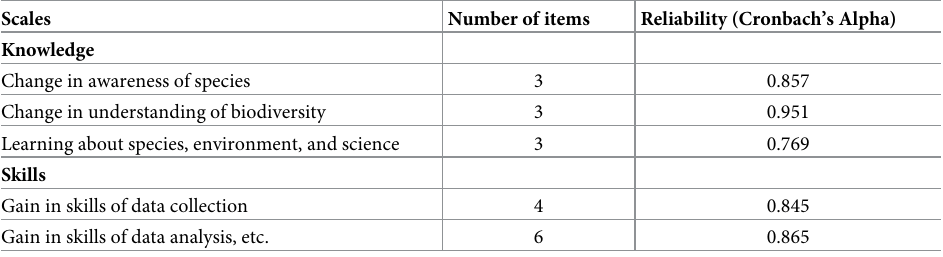
Table 3. Overview of scales for knowledge and skills (Peter et al.